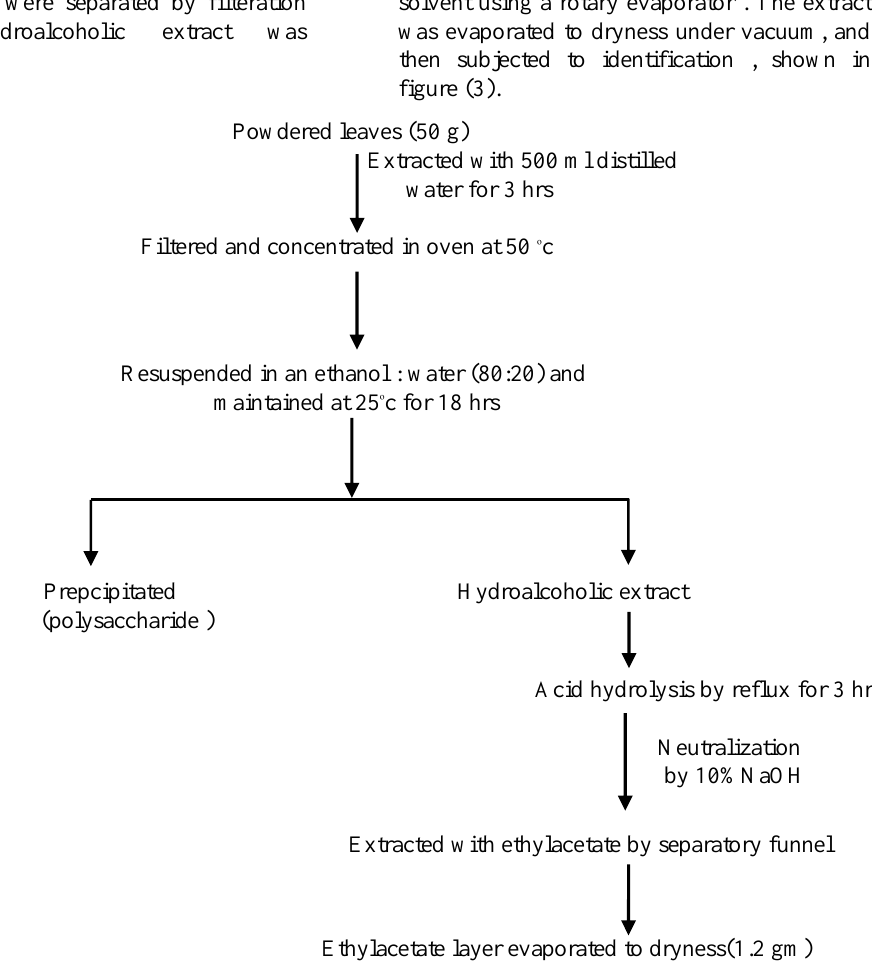
Figure(3):General scheme for method No.2 for extraction of steroidal sapogenin from the leaves of Agave americana